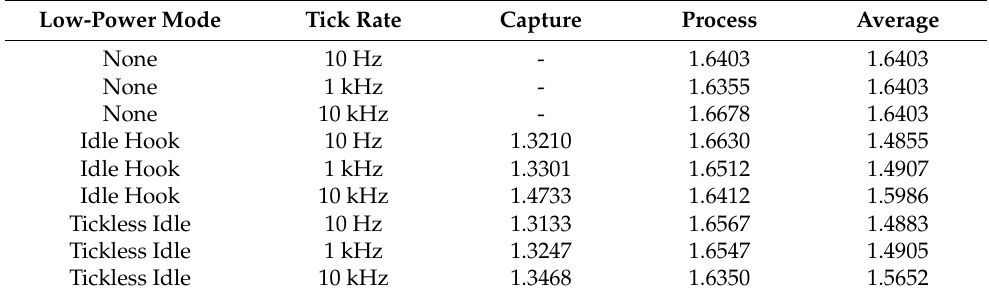
Table 4. Average supply current (mA) measured during Capture and Process states for various tick rates and low-power idle strategies.